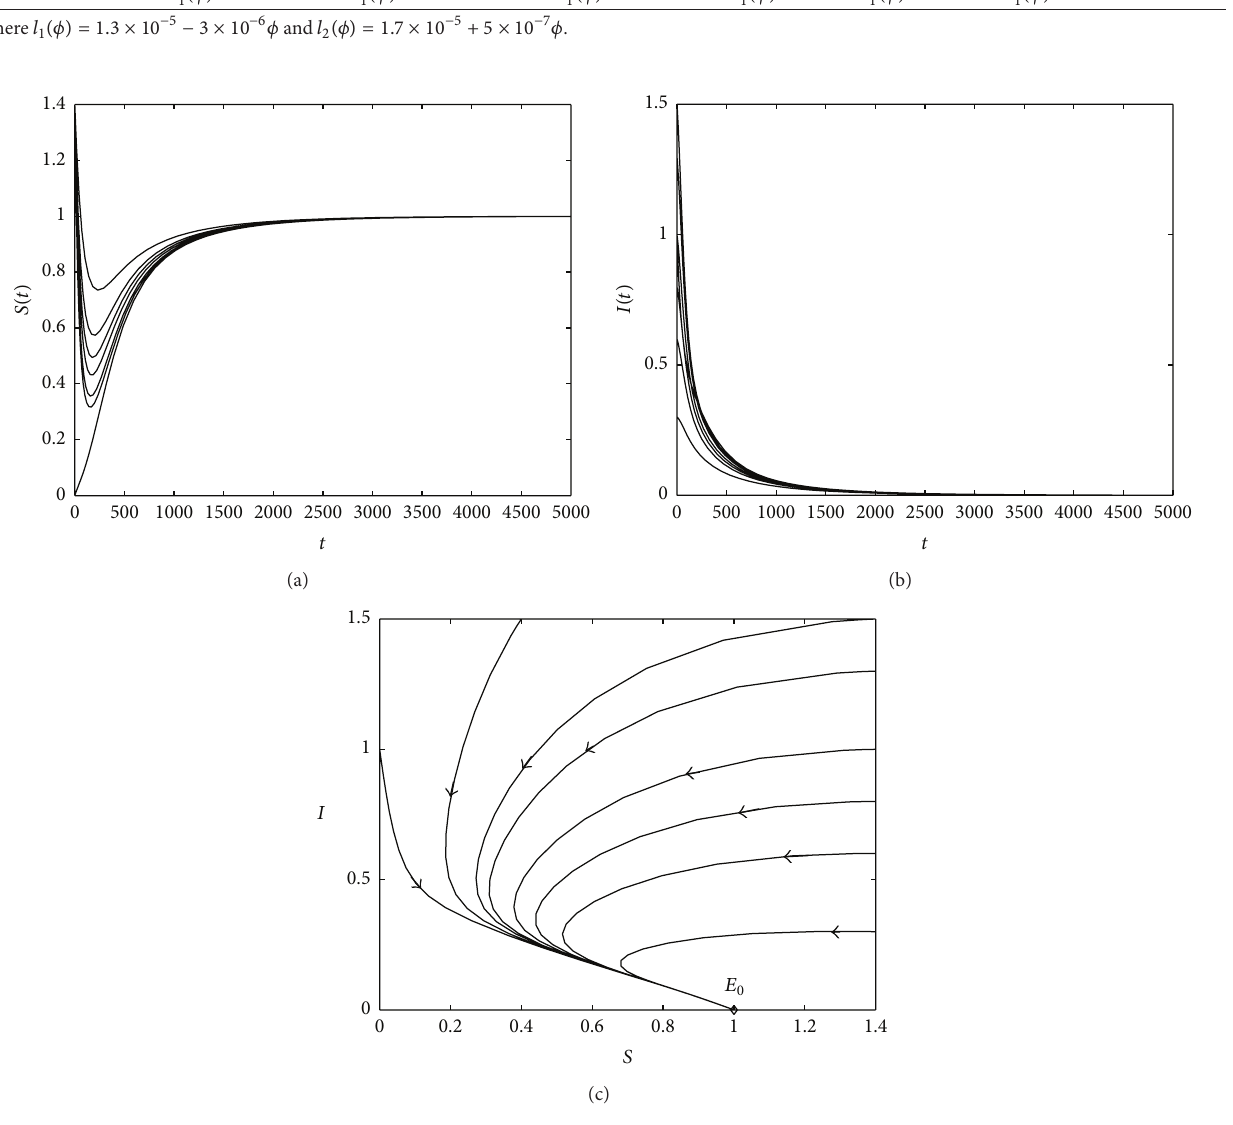
Figure 1: 𝜏 = 0 , 𝑅 0 < 1 . The solutions of system (6) approach to the disease-free equilibrium 𝐸 0 = (1,0)